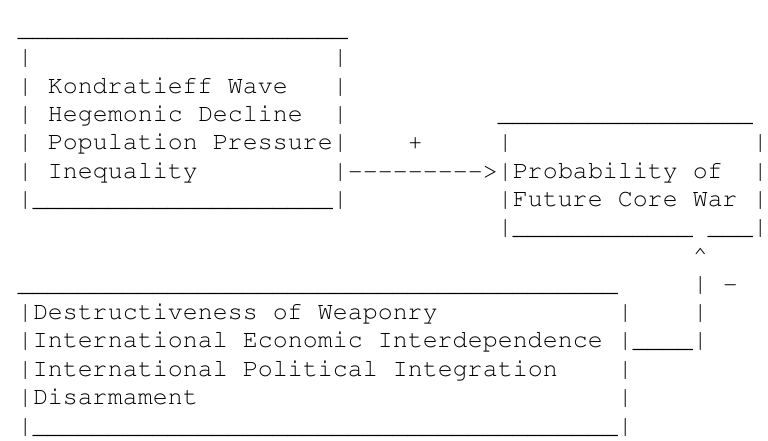
Figure 1: Factors influencing the probability of future core